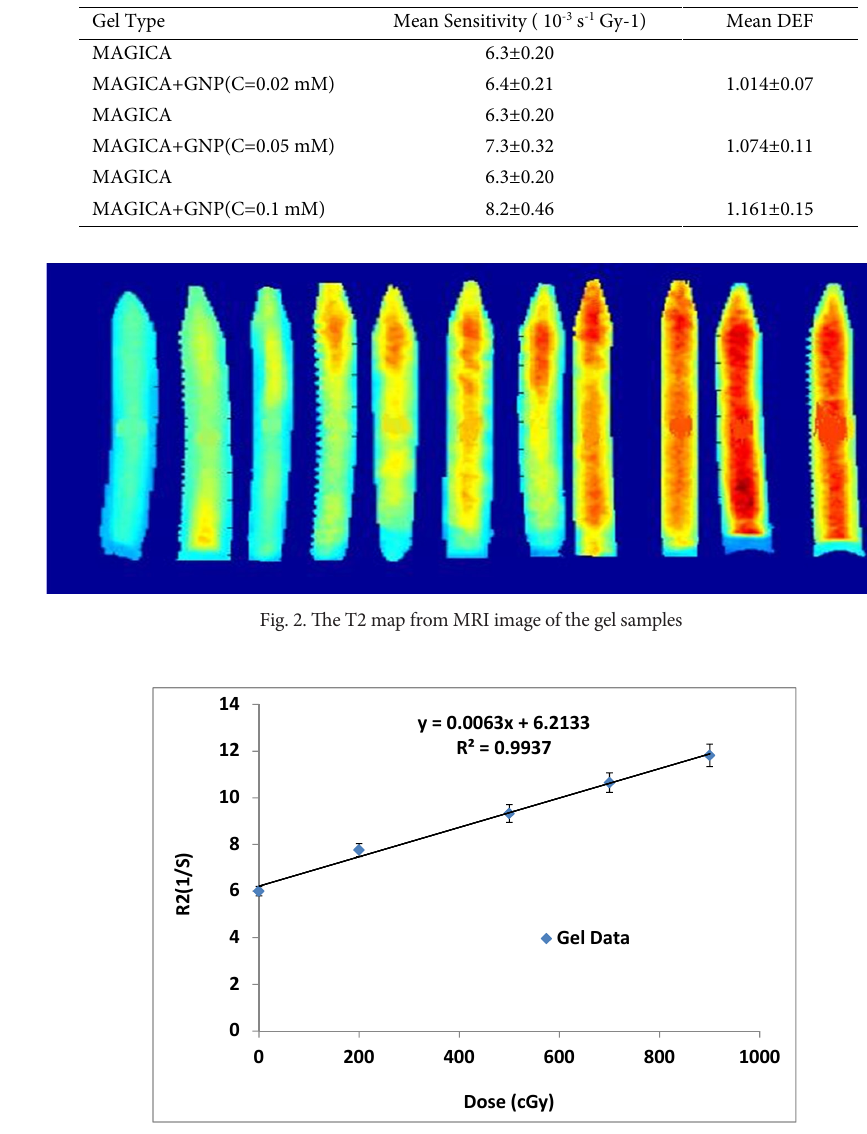
Fig. 3. MAGICA polymer gel dosimeter R2 response on absorbed dose in range of